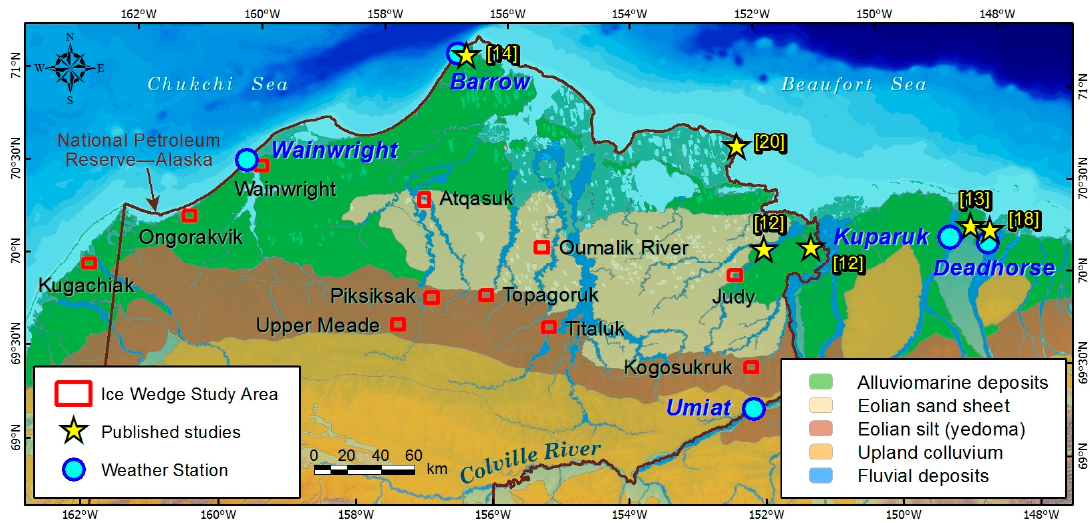
Figure 2. Locations of study sites, previously published studies (bracketed numbers), meteorological stations, and map of dominant geomorphic units adapted from Jorgenson and Grunblatt (2013) [26], North Slope, Alaska.